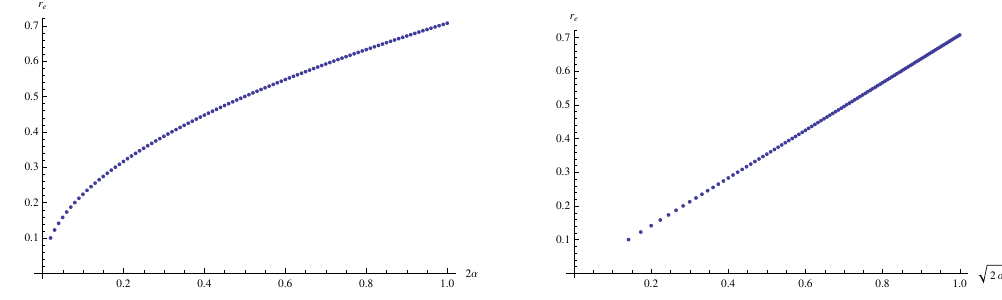
Figure 20 . The radius r = r e below which the numerical calculation is unreliable due to numerical instability for a 0 = 10 but di(cid:11)erent values of (cid:11) . The surface of the star r (cid:3) s is de(cid:12)ned by the relation r ( r (cid:3) s ) = a . The radius r e behaves as r e ’ (cid:11) 1 = 2